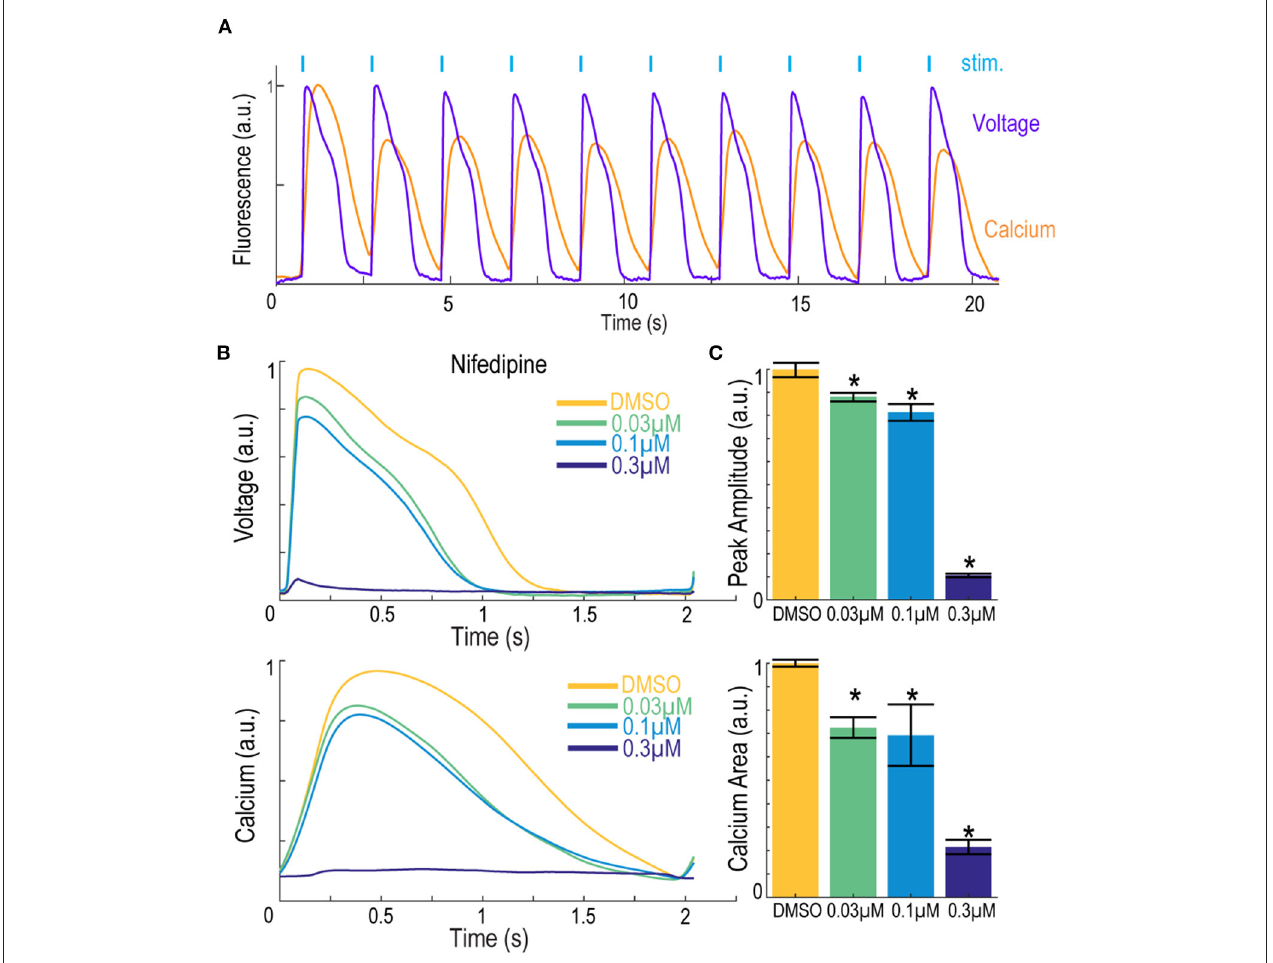
FIGURE 8 | Simultaneous voltage and calcium imaging with the Swarm instrument on hiPSC-derived cardiomyocytes. (A) Representative fluorescence traces from hiPSC-derived cardiomyocytes expressing jRGECO1a reporter and loaded with BeRST1 voltage sensitive dye. Cardiomyocytes were paced with ten 0.5Hz, 20ms blue pulses. (B) Average fluorescence waveforms for voltage and Ca 2 + in hiPSC-derived cardiomyocytes treated with increasing concentrations of calcium channel blocker Nifedipine (yellow to dark blue). (C) Quantification of voltage AP peak amplitude and integrated Ca 2 + waveform area. Data shown as mean from triplicate wells with ± SEM as error bars. * p < 0.05 compared to DMSO